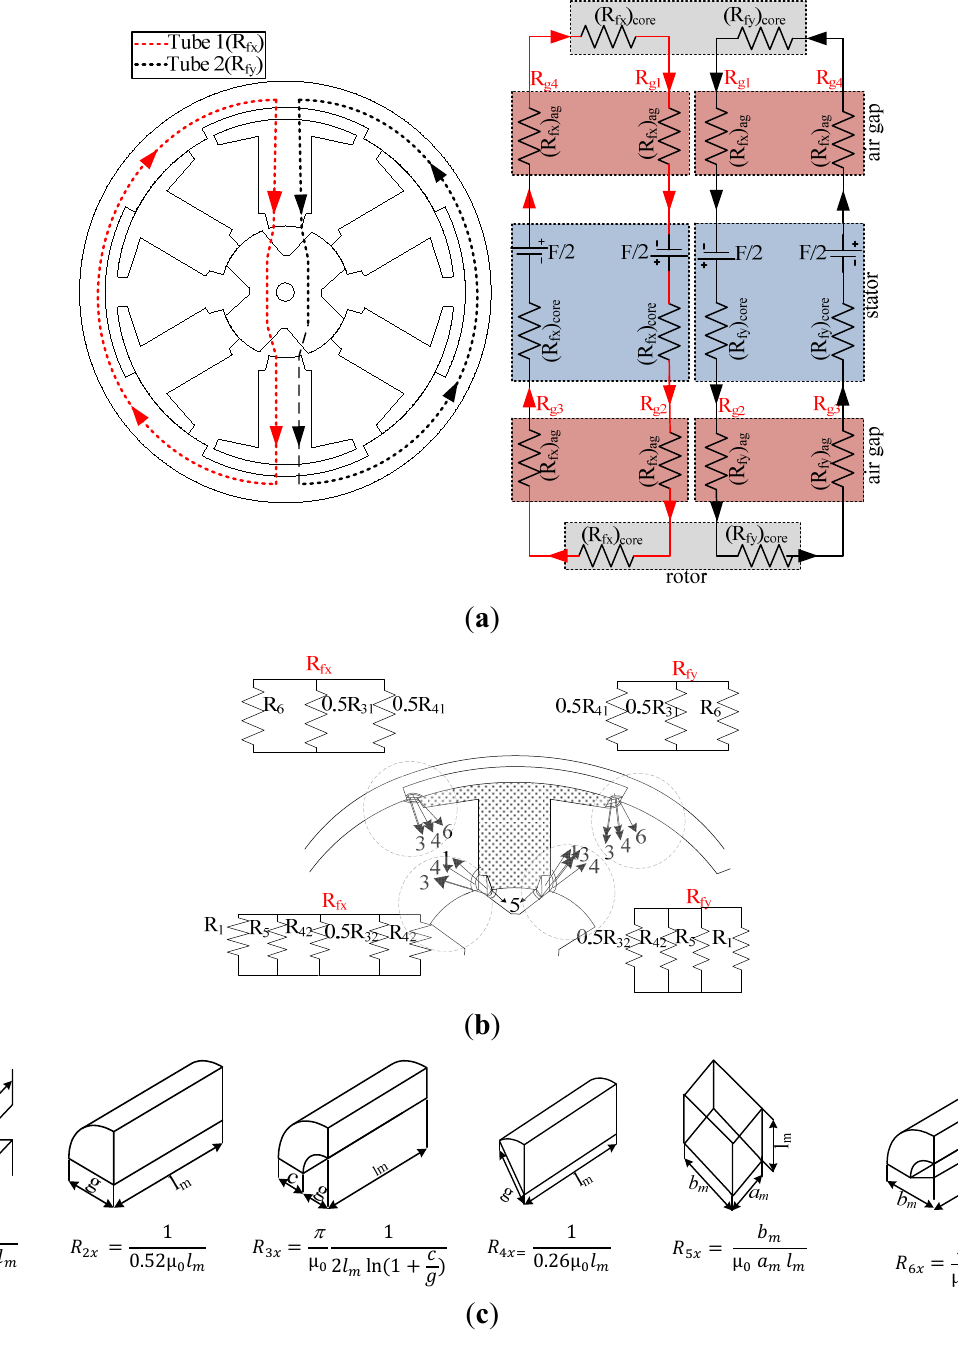
Figure 5. Reluctance in air-gap at unaligned position: ( a ) magnetic circuit at unaligned position; ( b ) reluctance shape assumptions; ( c ) reluctance shapes under